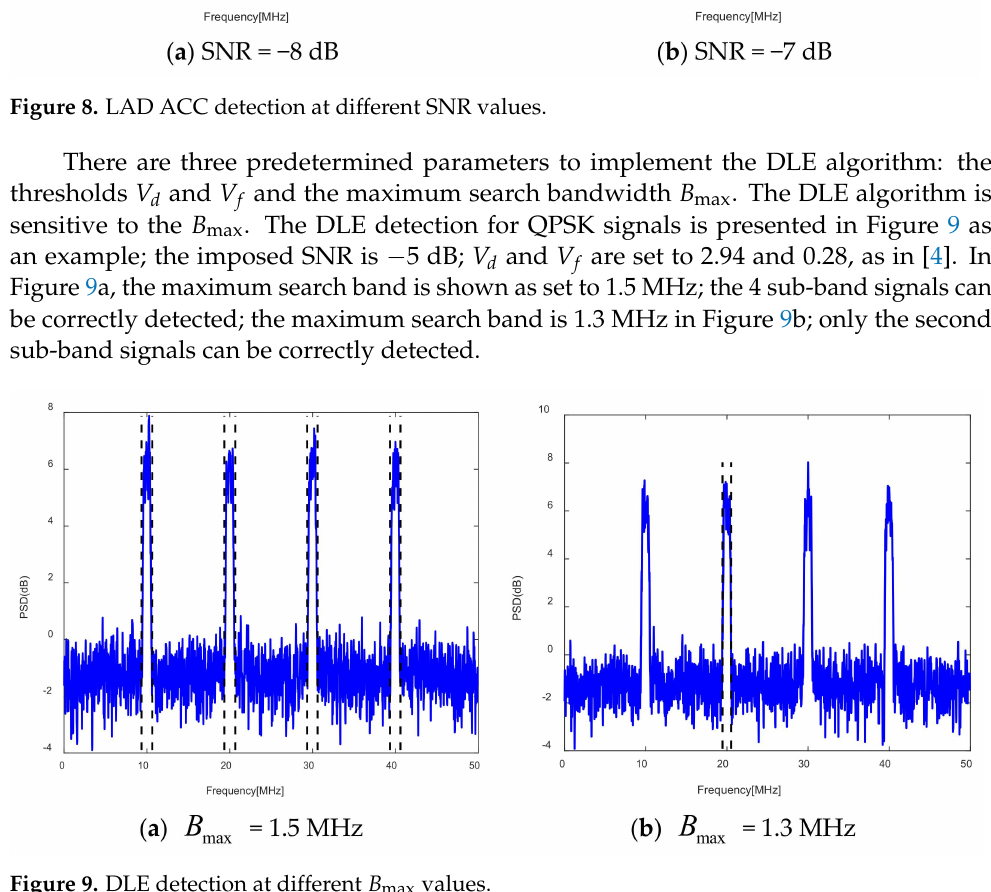
Figure 9. DLE detection at different B max